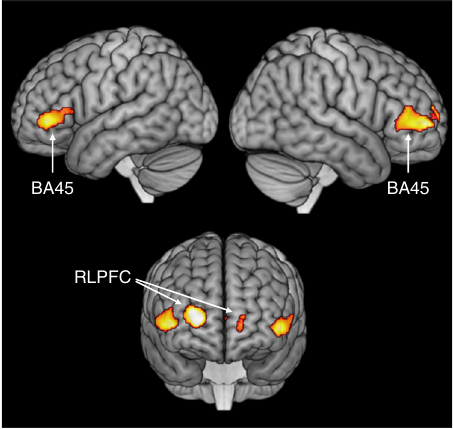
Fig. 4 Areas of greater activation when participants produced more was performed for each phase of the task, including region (BA45 vs. BA47) and hemisphere (left vs. right) as factors. There were signi fi cant effects of hemisphere for planning ( F (1,13) = 40.4, p < 0.001) and production ( F (1,13) = 10.5, p = 0.007), in both cases indicating greater activity in the left hemisphere. There were no main effects of region but there were region×hemisphere interactions for both phases of the task (planning: F (1,13) = 5.57, p = 0.035; production: F (1,13) = 5.07,